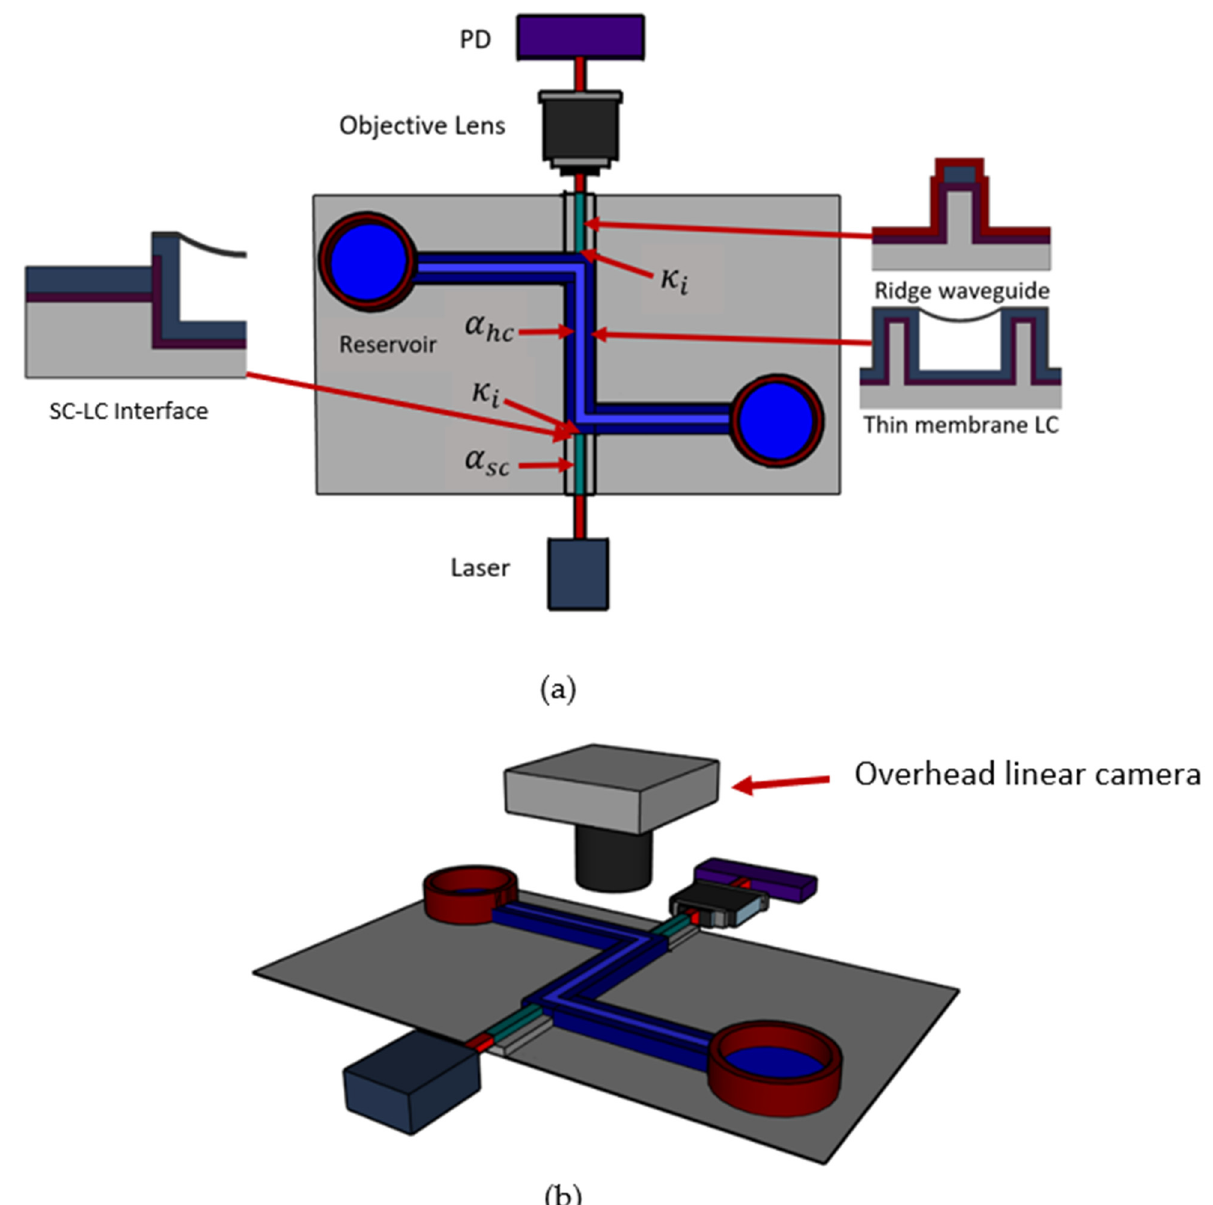
Figure 6. ( a ) Optical test bench setup for optofluidic waveguide characterization. Optical loss in the SC and LC channels were determined using 4 mm LC channels. α sc is the loss in the solid core, α hc is the loss in the hollow core, and κ i is the interface efficiency. ( b ) Loss test bench setup utilizing an overhead linear camera for top view scattering measurements.